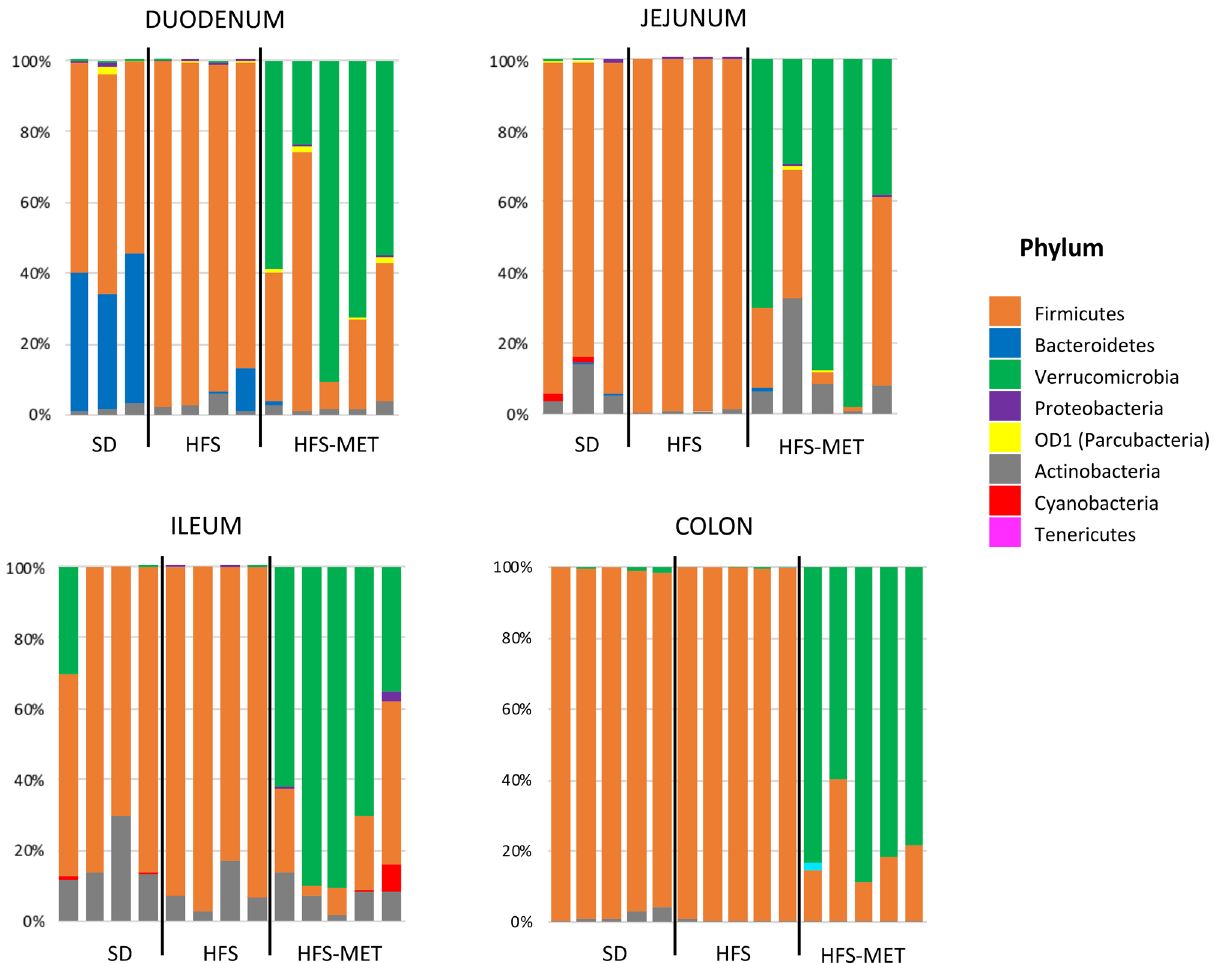
jejunum, ileum and colon of animals of the 3 groups ( SD standard diet, HFS high fat high sucrose diet, HFS- MET HFS diet with metformin supplementation). The figure represents the relative abundance of the main bacterial phyla measured in the luminal samples of individual